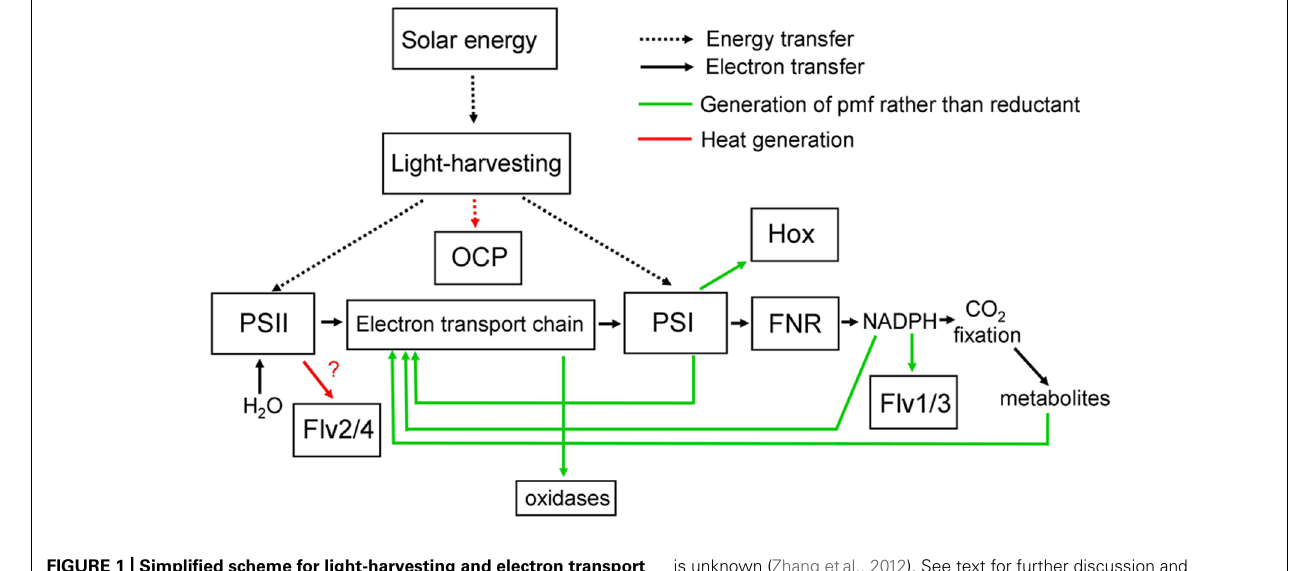
FIGURE 1 | Simplified scheme for light-harvesting and electron transport in cyanobacteria, showing alternative pathways and their principle functional consequences. Note that the functional consequences of electron transfer to Flv2/4 are uncertain, as the subsequent electron acceptor